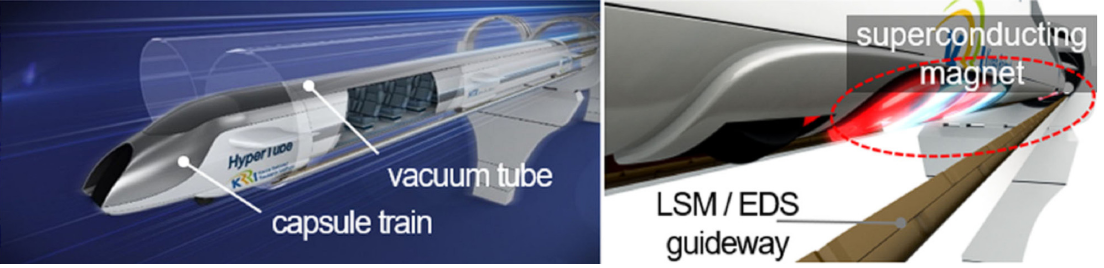
Figure 4. Hyperloop concept [12].